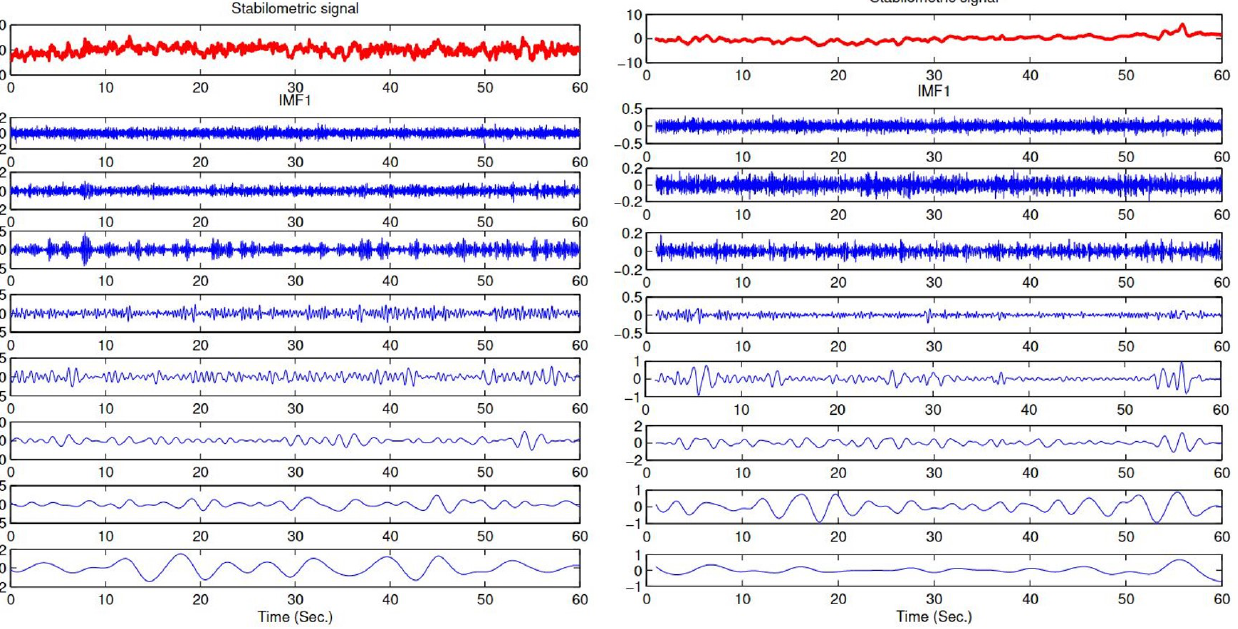
Figure 1. AP stabilometric signal and its first eight IMFs for PD ( left ) and healthy ( right )